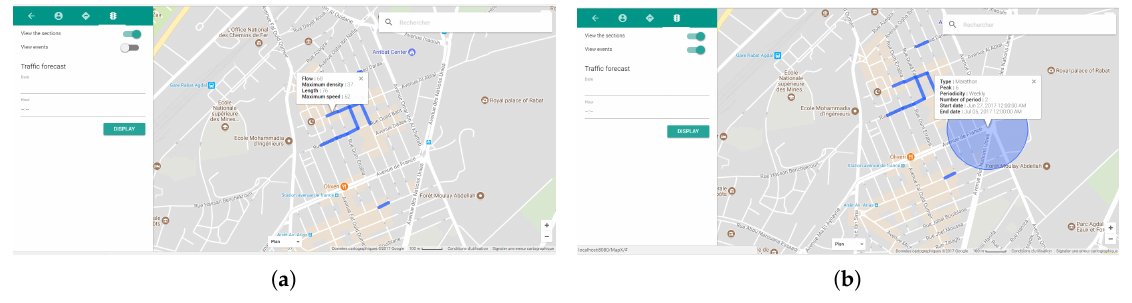
Figure 10. Illustration of the road network visualizer application. ( a ) The main characteristics of a road section; ( b ) An event occurs in a geographical